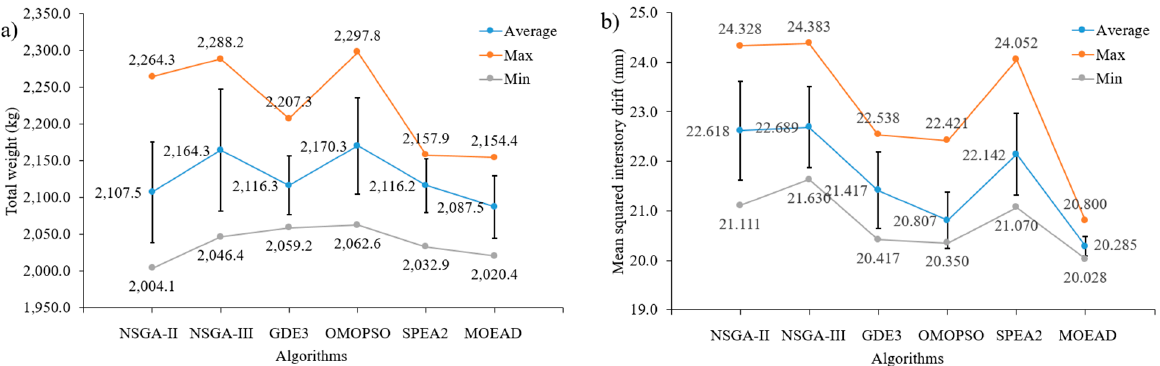
Figure 6. Spread illustration of the optimal solutions in the 10-bar truss regarding the ( a ) first objective; ( b ) second objective.